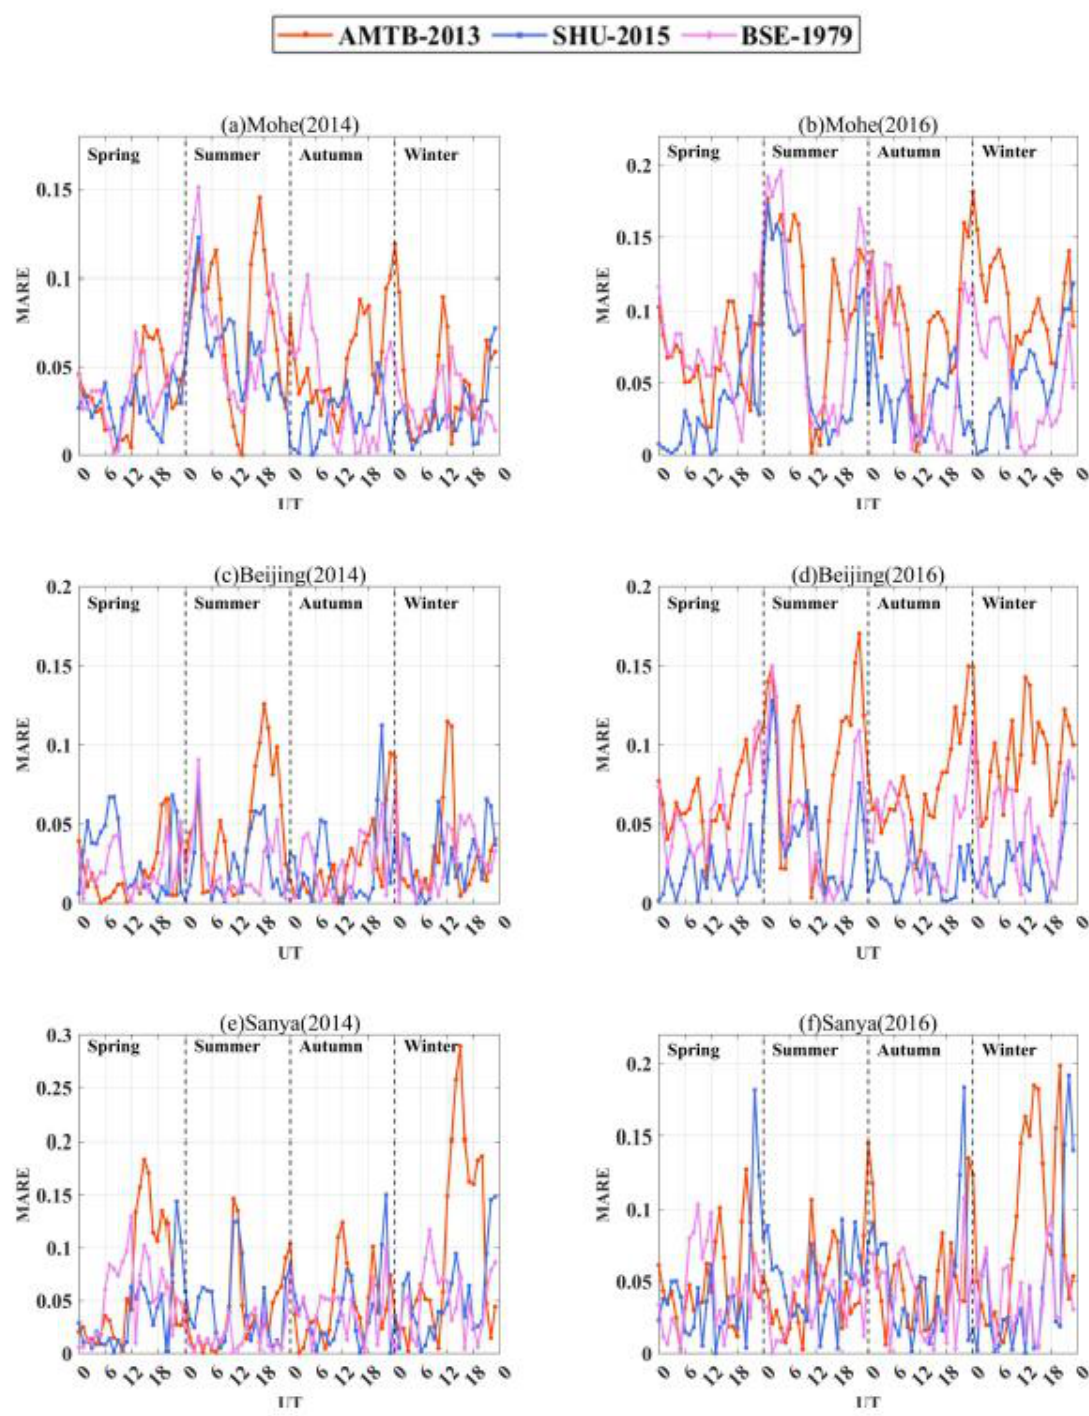
Figure 9. Diurnal MARE variation for three IRI-2016 predicted hmF2 from the ionosonde hmF2 in the four different seasons of the years 2014 and 2016 at Mohe, Beijing and Sanya over China. ( a ) Mohe(2014), ( b ) Mohe(2016), ( c ) Beijing(2014), ( d ) Beijing(2016), ( e ) Sanya(2014), ( f ) Sanya(2016).